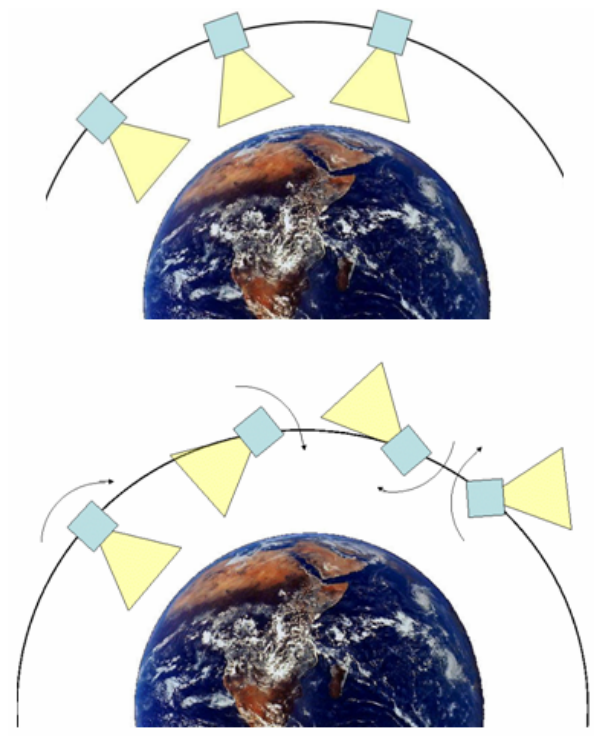
Fig. 11. Top: Imager mounted on a three-axis stabilised (despun) platform, with FOV directed toward nadir. Bottom: Spin stabilised spacecraft, imager FOV is scanned over